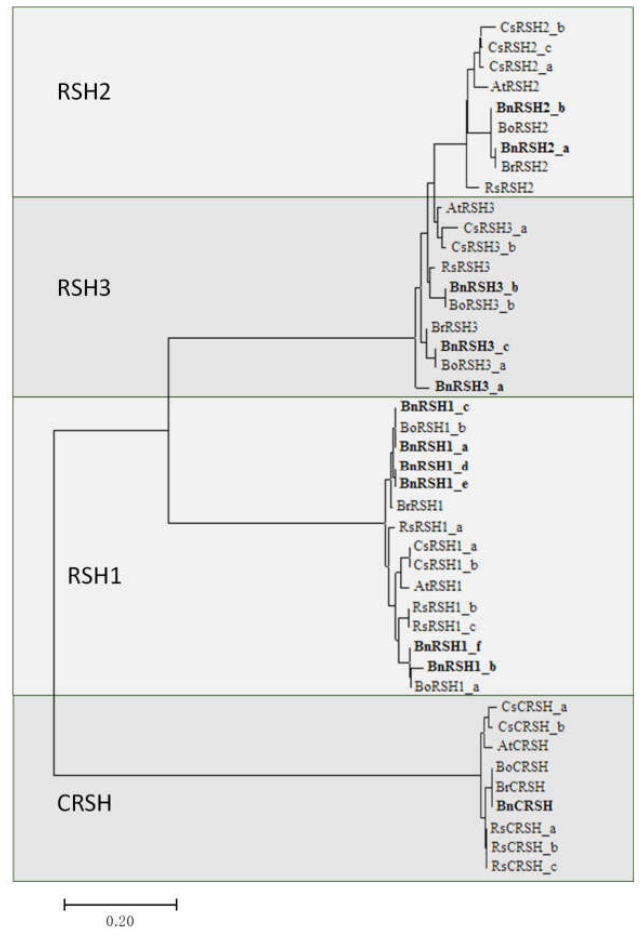
Figure 5. The phylogenetic analysis of RSH proteins based on predicted amino acid sequences